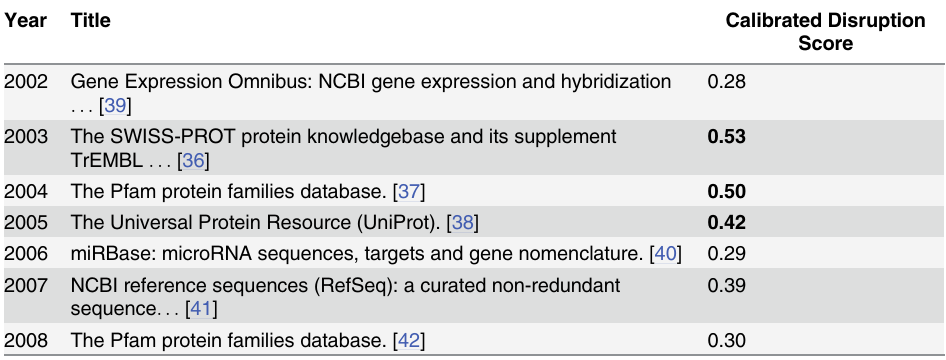
Table 3. 5-year calibrated disruption scores of the most highly cited articles in the database special issue of